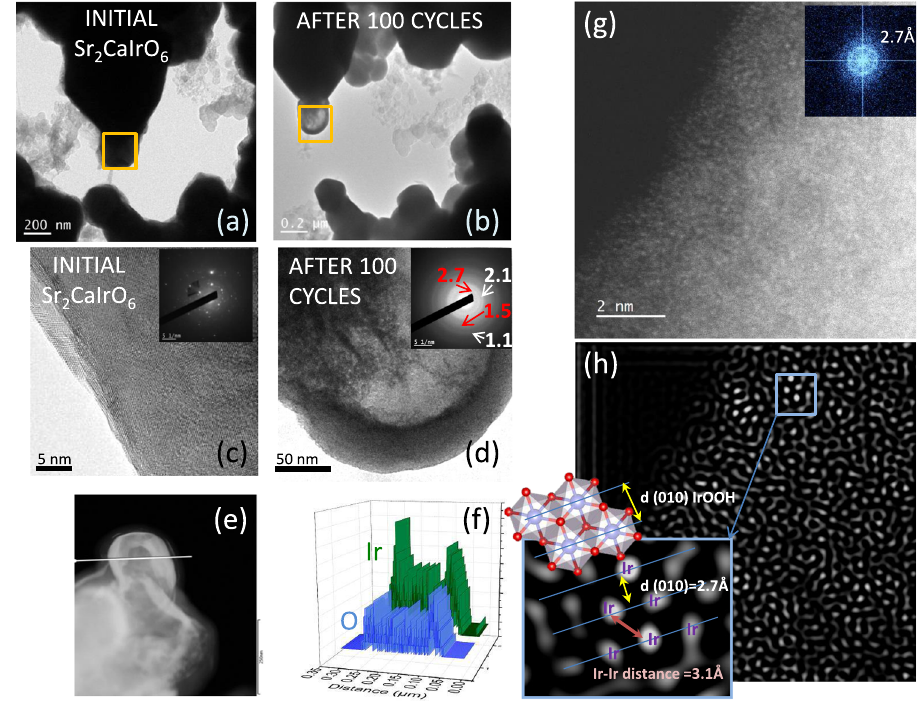
Fig.3|MorphologyandstructureofthehollowIr-Oparticles. IL-TEMofaregion of Sr 2 CaIrO 6 ( a ) before and ( b ) after 100 OER cycles. ( c ) HRTEM of the initial catalyst. d – f TEM,STEMand EDXimages of thehollow regions composed ofIrand O. Inset of Fig.d: SAED pattern. Note that diffraction rings at 2.1 and 1.1Å appear